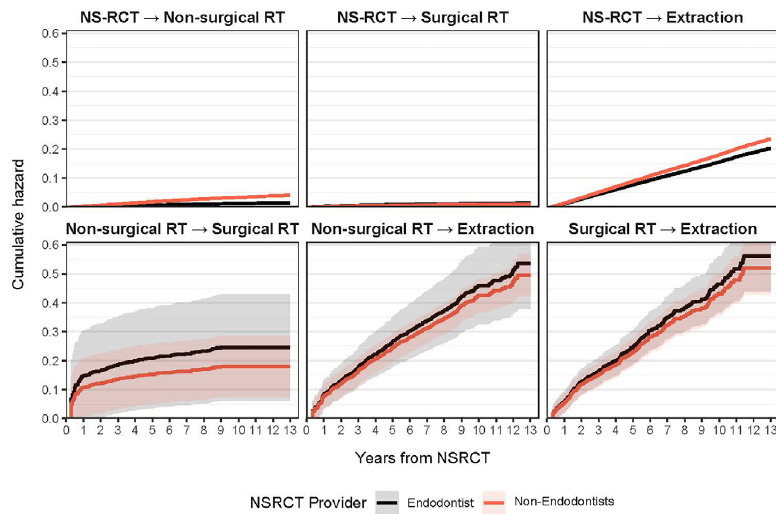
Figure 3- Cumulative hazard plot demonstrating time to the next transition state based on initial provider type Table 3- Probability (SE) of being in each state at select Timepoint